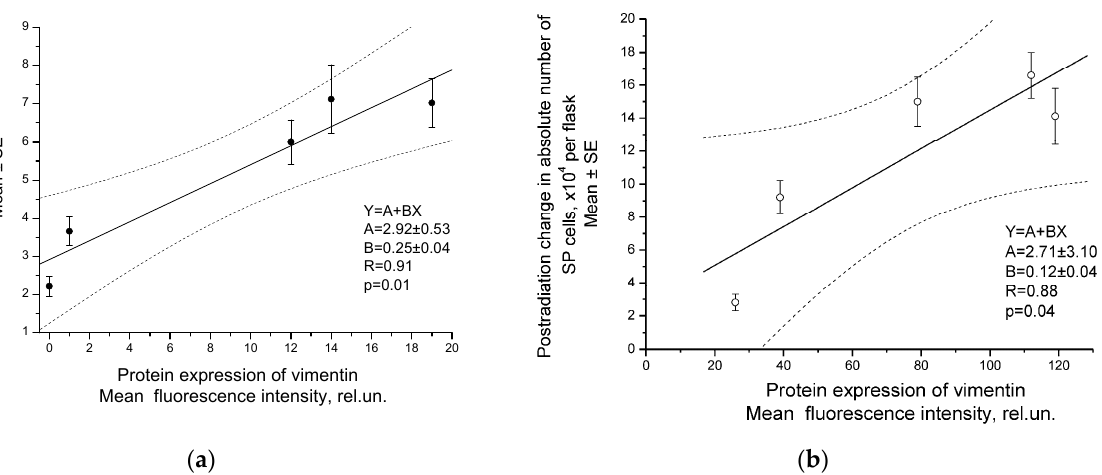
Figure 10. Correlation of postradiation changes in the absolute number of SiHa ( a ) and HeLa ( b ) SP cells with protein expression of vimentin determined by flow cytometry 24 h after fractionated radiation exposure at TDs of 2–10 Gy. Vimentin expression was assessed by the fluorescence intensity of cells stained with antibodies to vimentin after subtracting the mean intensity of nonspecific binding in the control samples. The parameters of the linear regressions Y = A + BX are indicated, where X is vimentin expression and Y is changes in the absolute number of SP cells after irradiation. The dotted lines indicate 95% confidence limits for linear regression (solid line). A similar correlation was observed between postradiation changes in the number of CD133+ CSCs and the protein expression of vimentin in SiHa cells (Figure 11). In addition, a high correlation was found between the radiation changes in the CSC pool and the mRNA expression of vimentin after irradiation at TDs of 2–10 Gy (R = 0.94, p = 0.02).